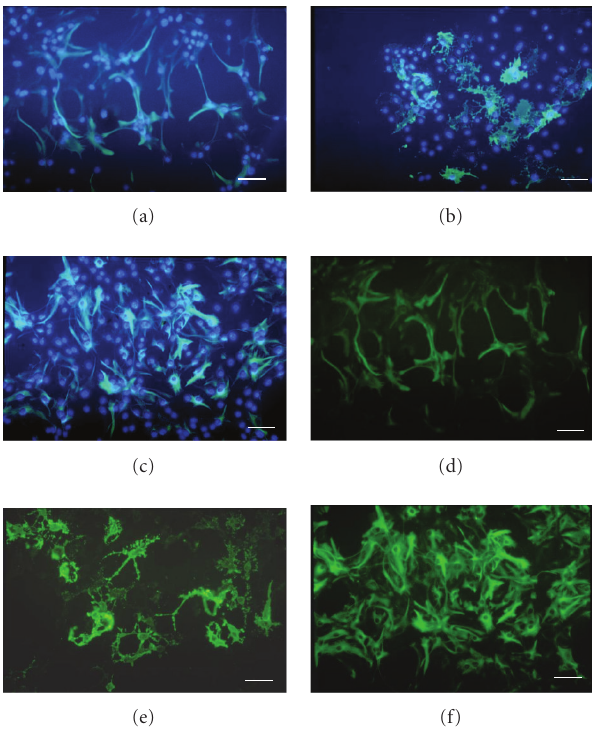
Figure 5: Immunolocalization of nestin, A2B5, and GFAP in S10 neurospheres. In (a), (b), and (c), double immunostaining of nestin/Hoechst, A2B5/Hoechst, and GFAP/Hoechst is shown, re- spectively. In (d), (e), and (f), the single immunostaining is shown. Bar = 40 μ m.